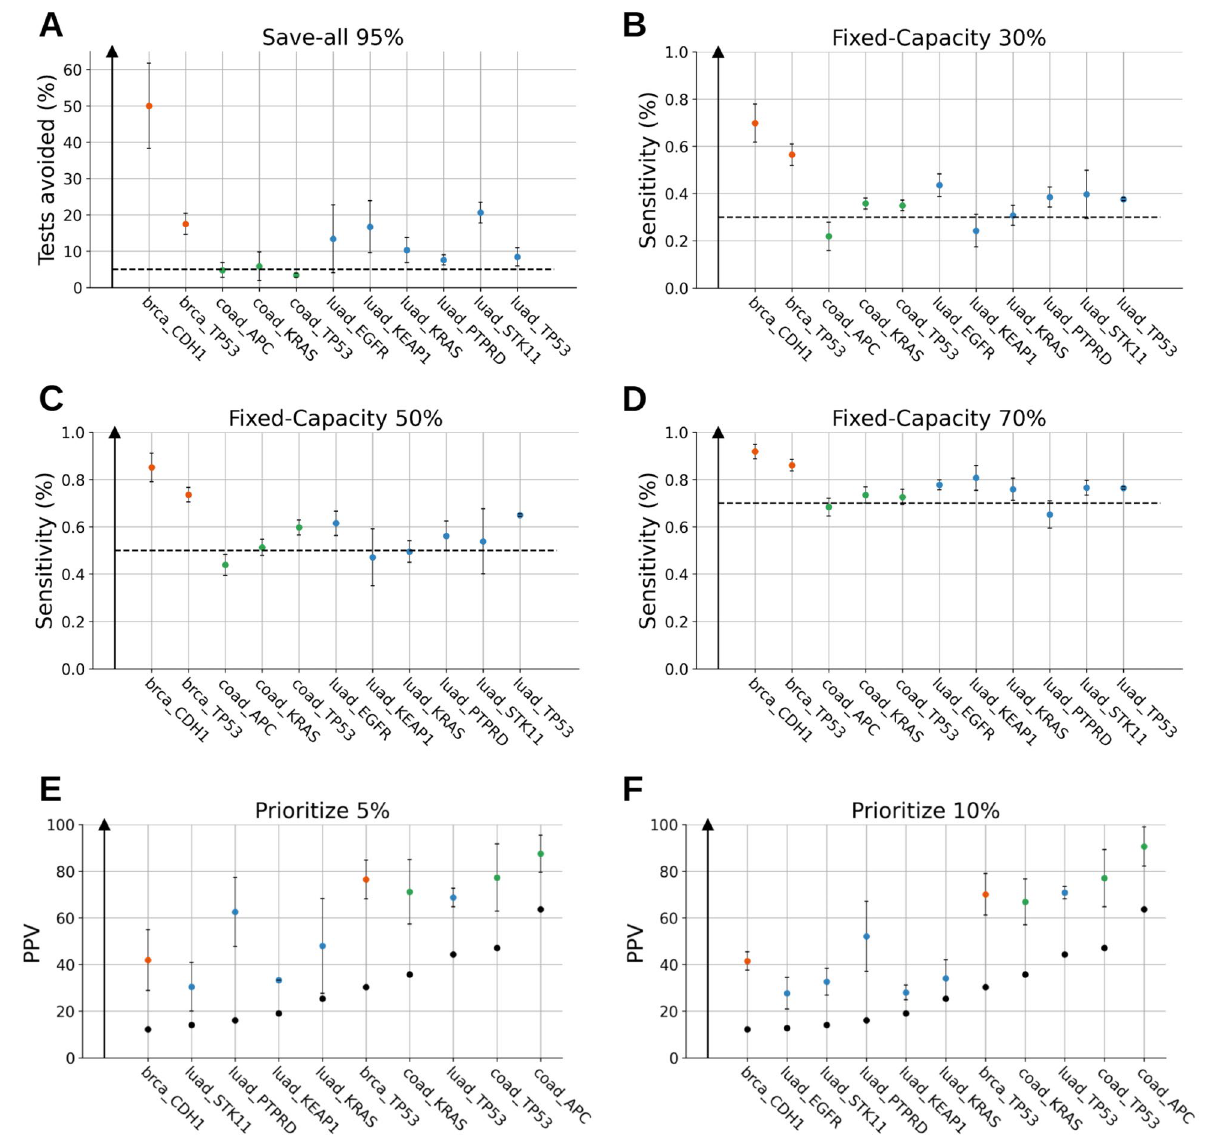
Figure 3. Performance of the screening pipeline for the 3 screening strategies on multiple genes. ( A ) Percentage of avoided tests at a sensitivity threshold of 5% respectively (save-all strategy). The colors correspond to the dataset of origin using the same code as in Fig. 1. The error bar shows the standard deviation of the mean. ( B – D ) Sensitivity for the fixed-capacity strategy with a DNA sequencing test capacity of respectively 30%, 50% and 70%. The colors correspond to the dataset of origin using the same code as in Fig. 1. The dashed horizontal line corresponds to the expected sensitivity in a random selection context. The error bar shows the standard deviation of the mean. ( E – F ) Positive predictive value for the priority strategy using a threshold of top 5% and top 10% selection of patients most at risk of being mutated. The colors correspond to the dataset of origin using the same code as in Fig. 1. The black dots represent the prevalence for each gene, which is the expected positive predictive value in a random context. The error bar shows the standard deviation of the